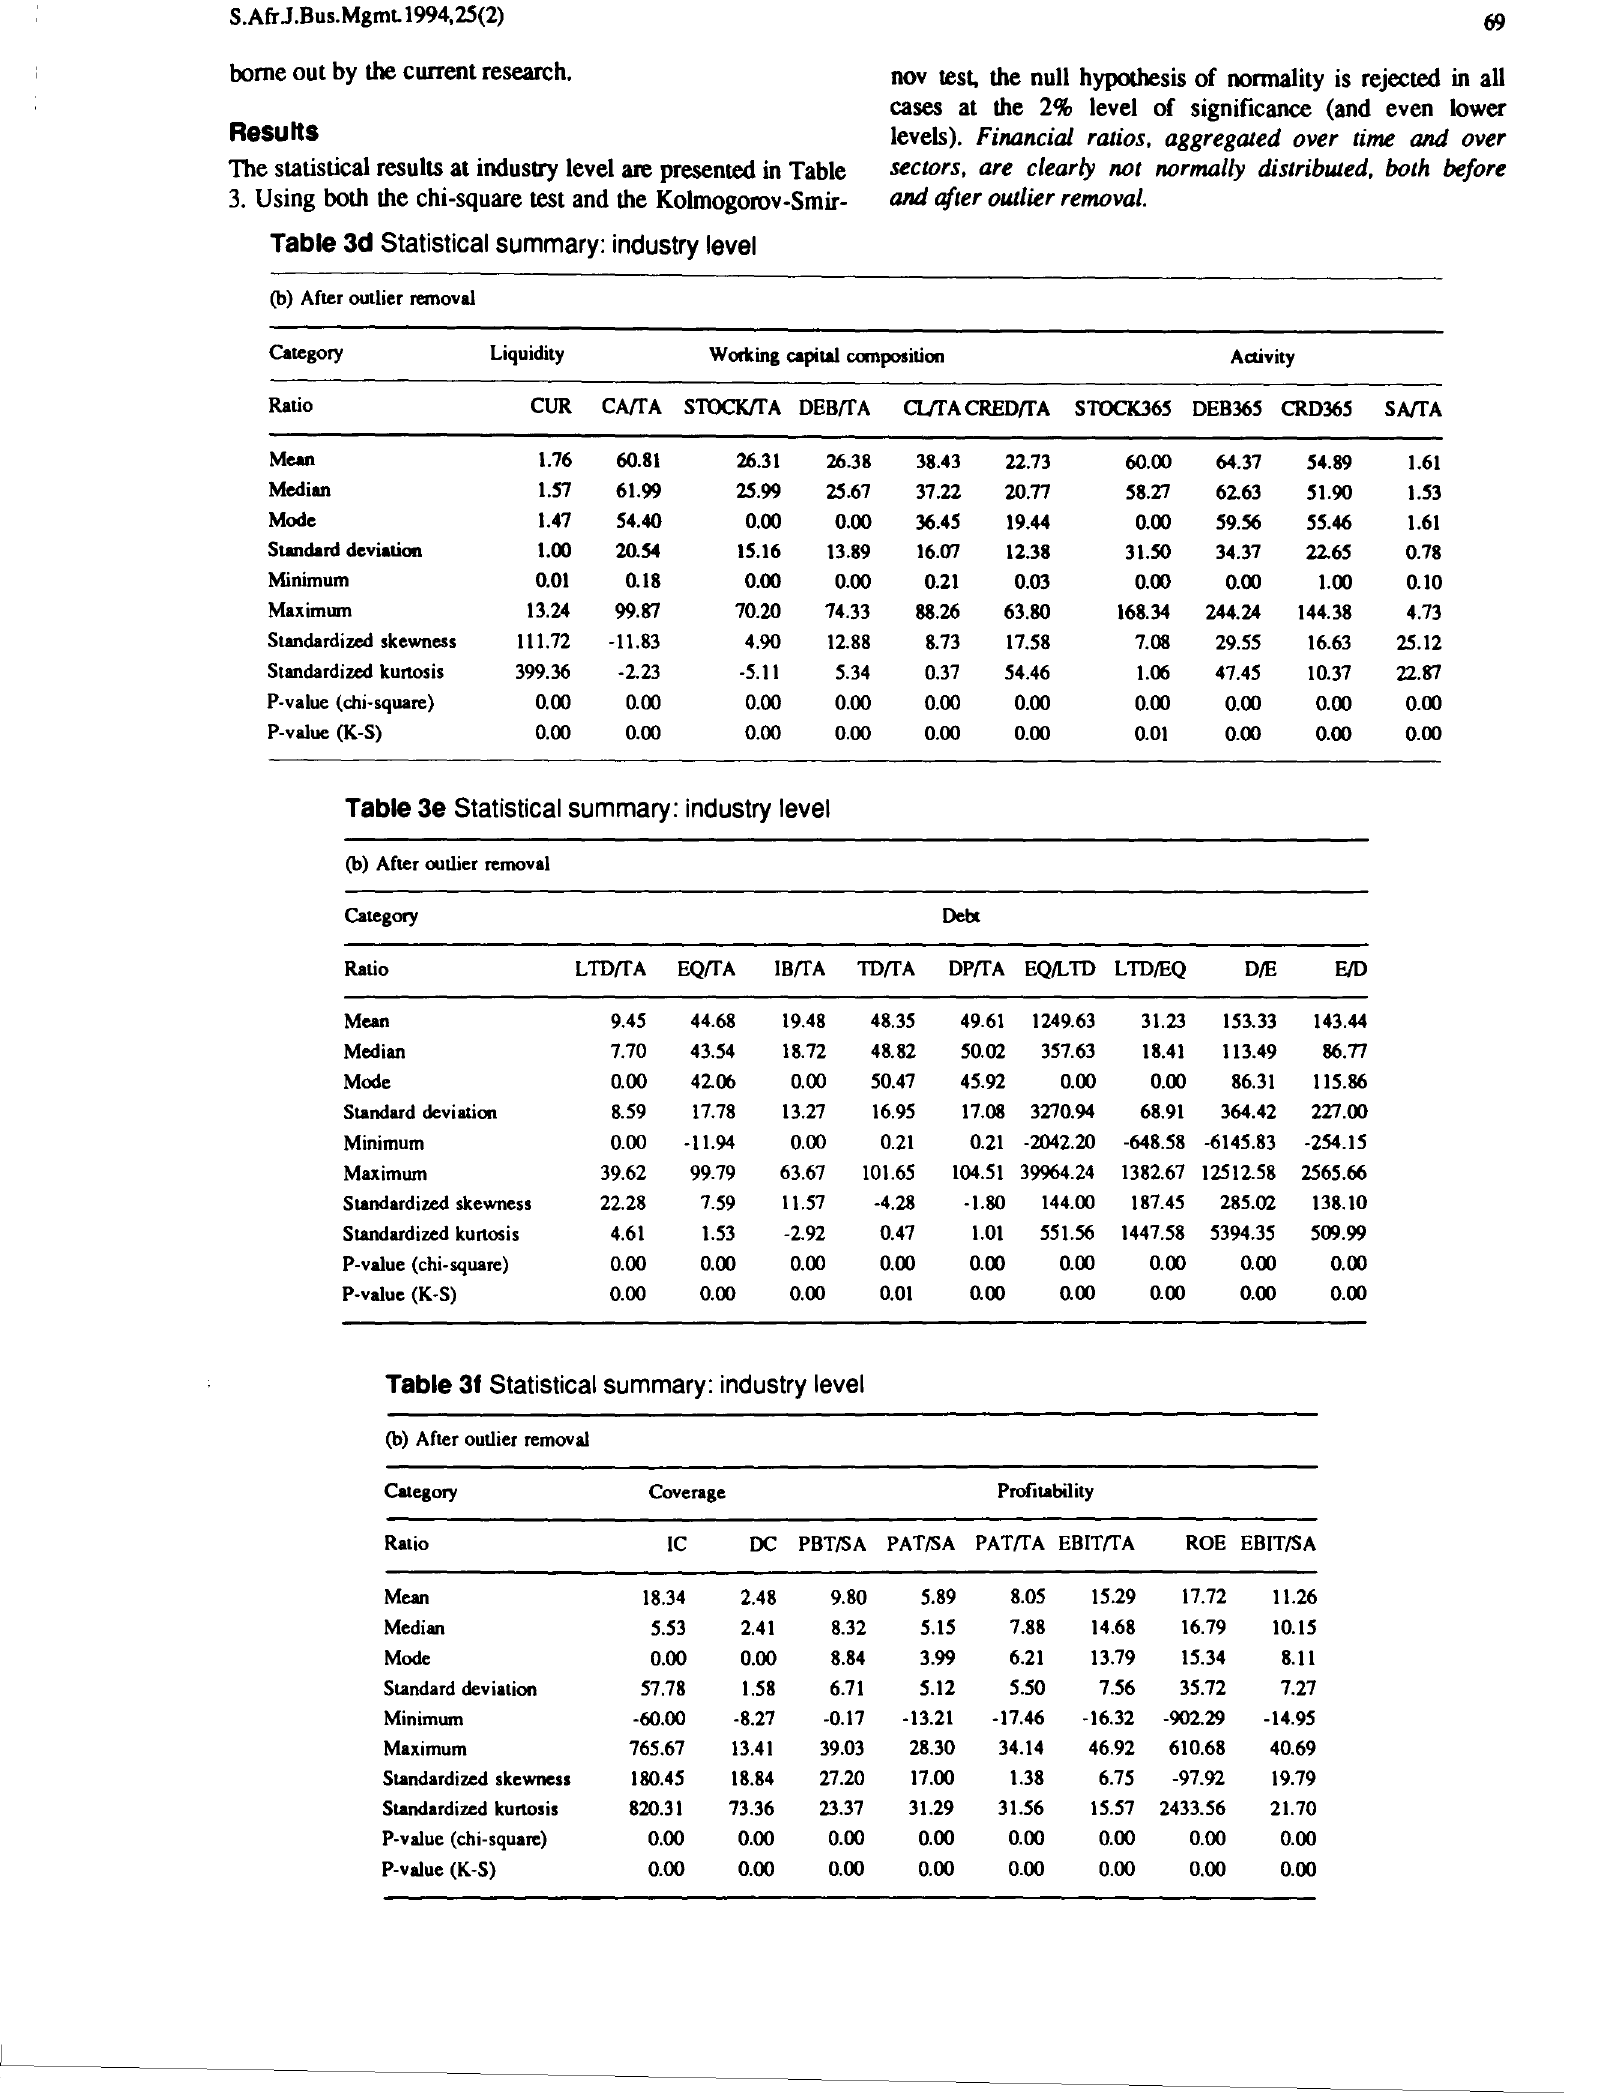
Table 31 Statistical summary: industry